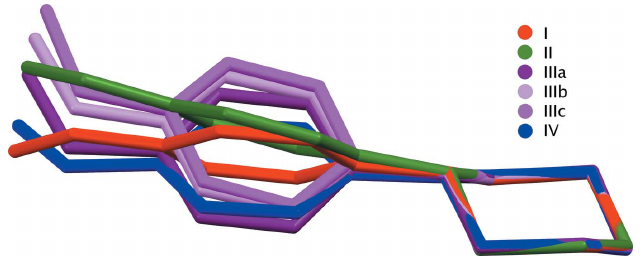
Figure 5 An overlay of six 4-MeOPP cations (least-squares fit of piperazinium ring atoms), showing the variability of MeOPP conformation across structures I – IV